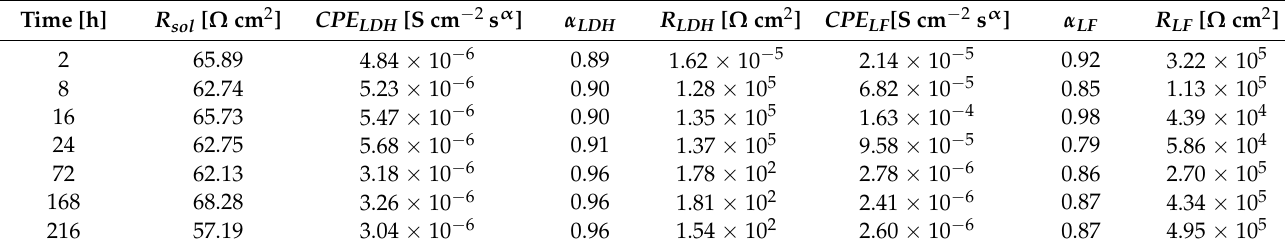
Table 4. Results of EIS fitting for C10-9 sample.